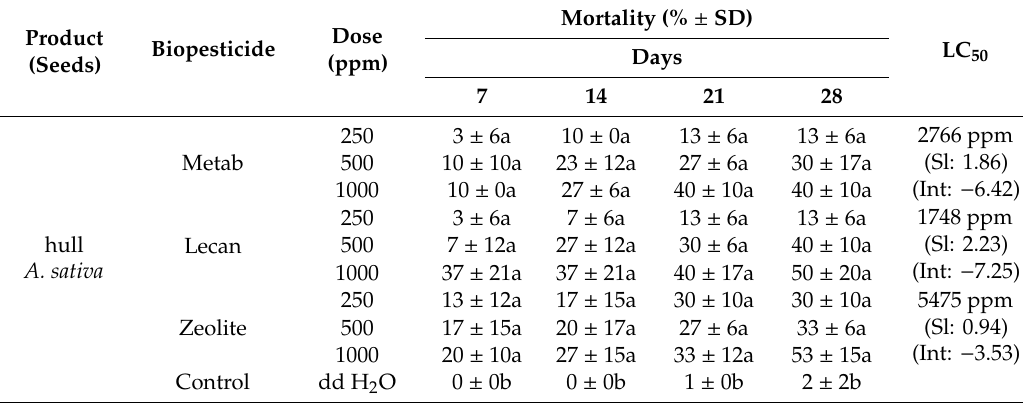
Table 4. Mean mortality (% ± SD) and median lethal concentration (LC 50 with (Sl) and Intercept (Int) values) of T. confusum adults exposed for 28 days to hull A. sativa seeds that had been treated with Metab, Lecan, and Zeolite, at three dose rates. Mean ± SD values with the same letter within a column are not significantly di ff erent ( p < 0.05) ( F = .939, df = 6.96, p =